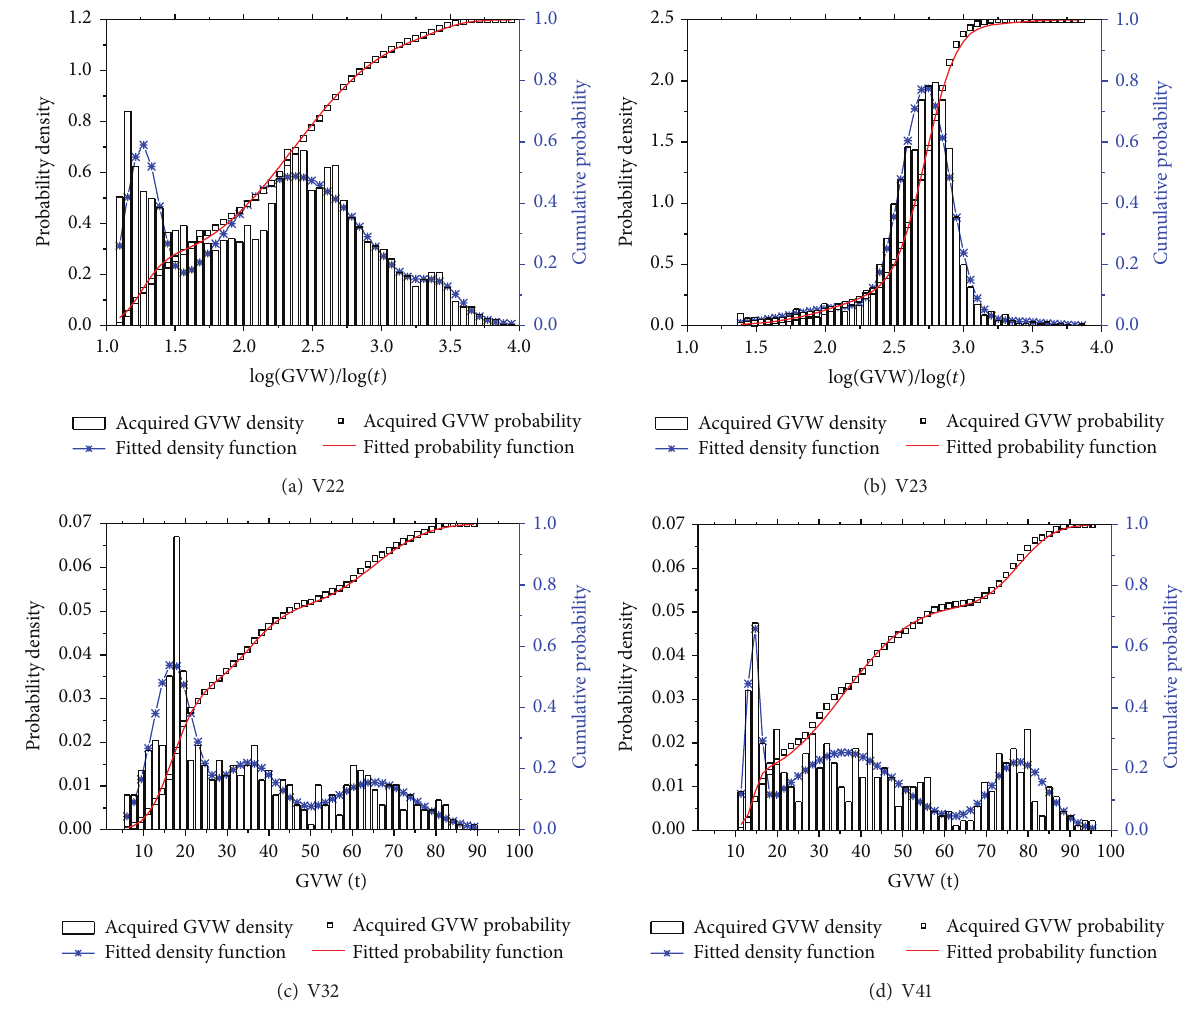
Figure 5: Probability distribution of GVW for different truck types.